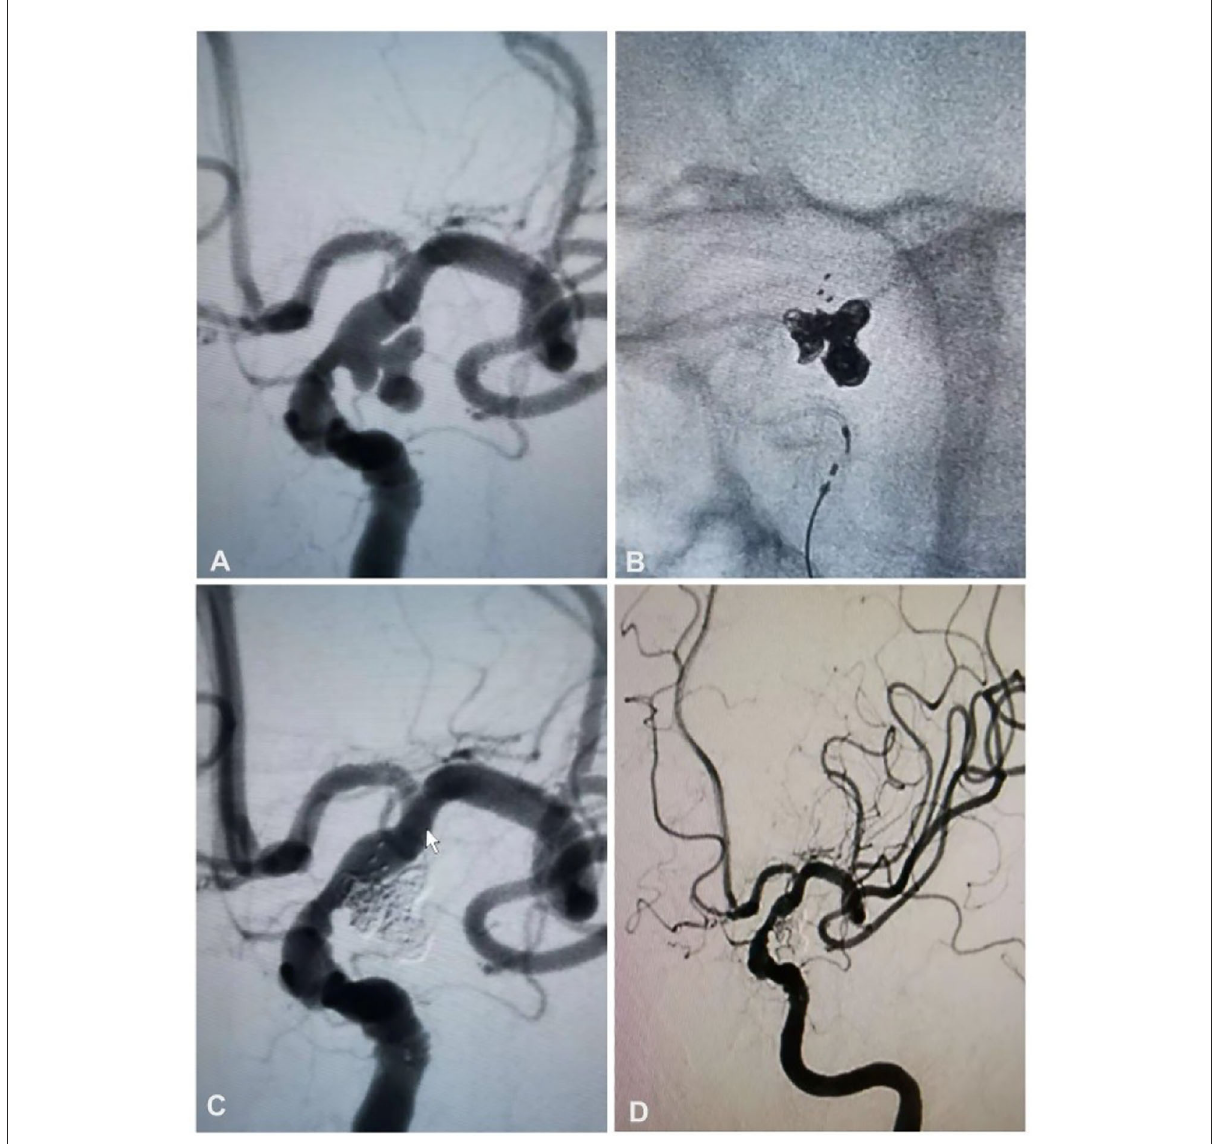
FIGURE2 A 63-year-old woman had a ruptured aneurysm at the posterior communicating artery (Pcom) of the left internal carotid artery and was treated with stent-assisted coiling. (A) Angiography revealed an aneurysm at the left Pcom. (B) Stent-assisted coiling was performed with a Solitaire AB stent (4 × 20mm) and six coils. (C) The aneurysm was totally occluded. (D) Follow-up angiography at 6 months revealed that the aneurysm was still totally